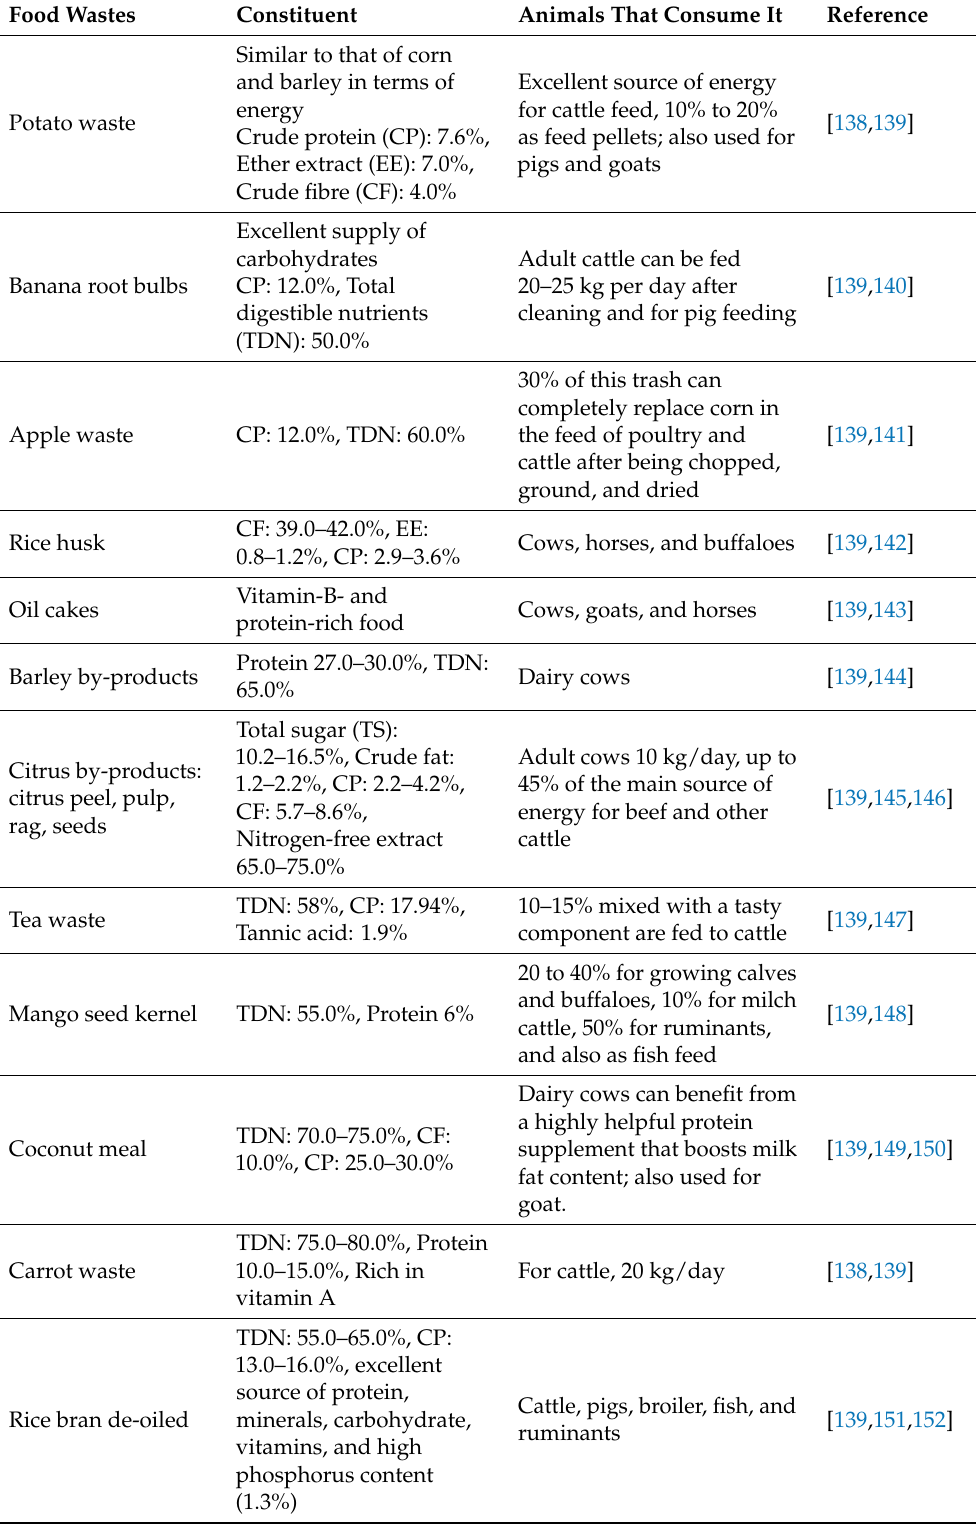
Table 3. Types of FWs/by-products and their uses as animal